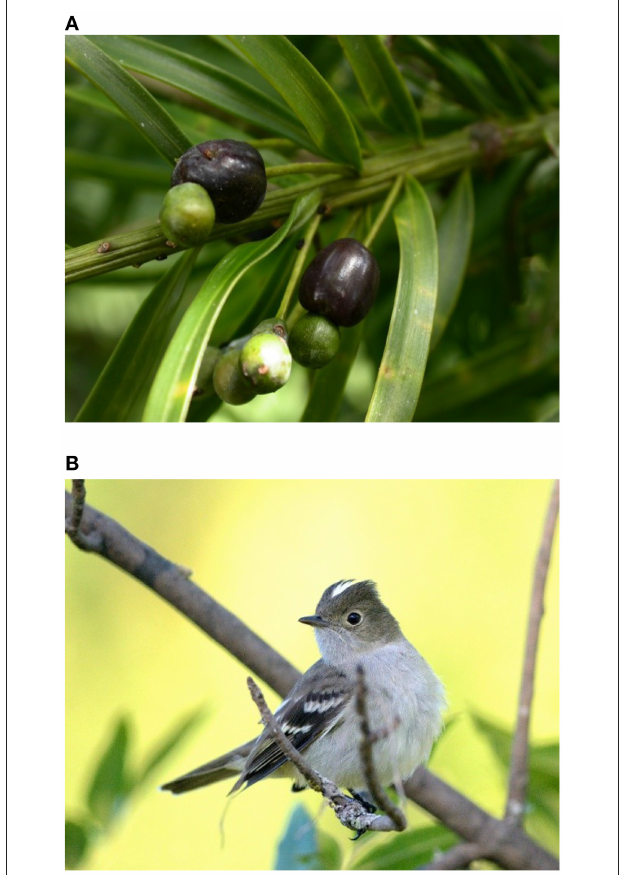
FIGURE 1 | (A) Ripe cone (“fruit”) of Podocarpus parlatorei showing the fleshy basal receptacle and the single seed attached to the apex of the receptacle (photo of the author). (B) Elaenia albiceps was the largest contributor to the overall seed dispersal effectiveness of P. parlatorei in old-growth forests (photo by Rodrigo